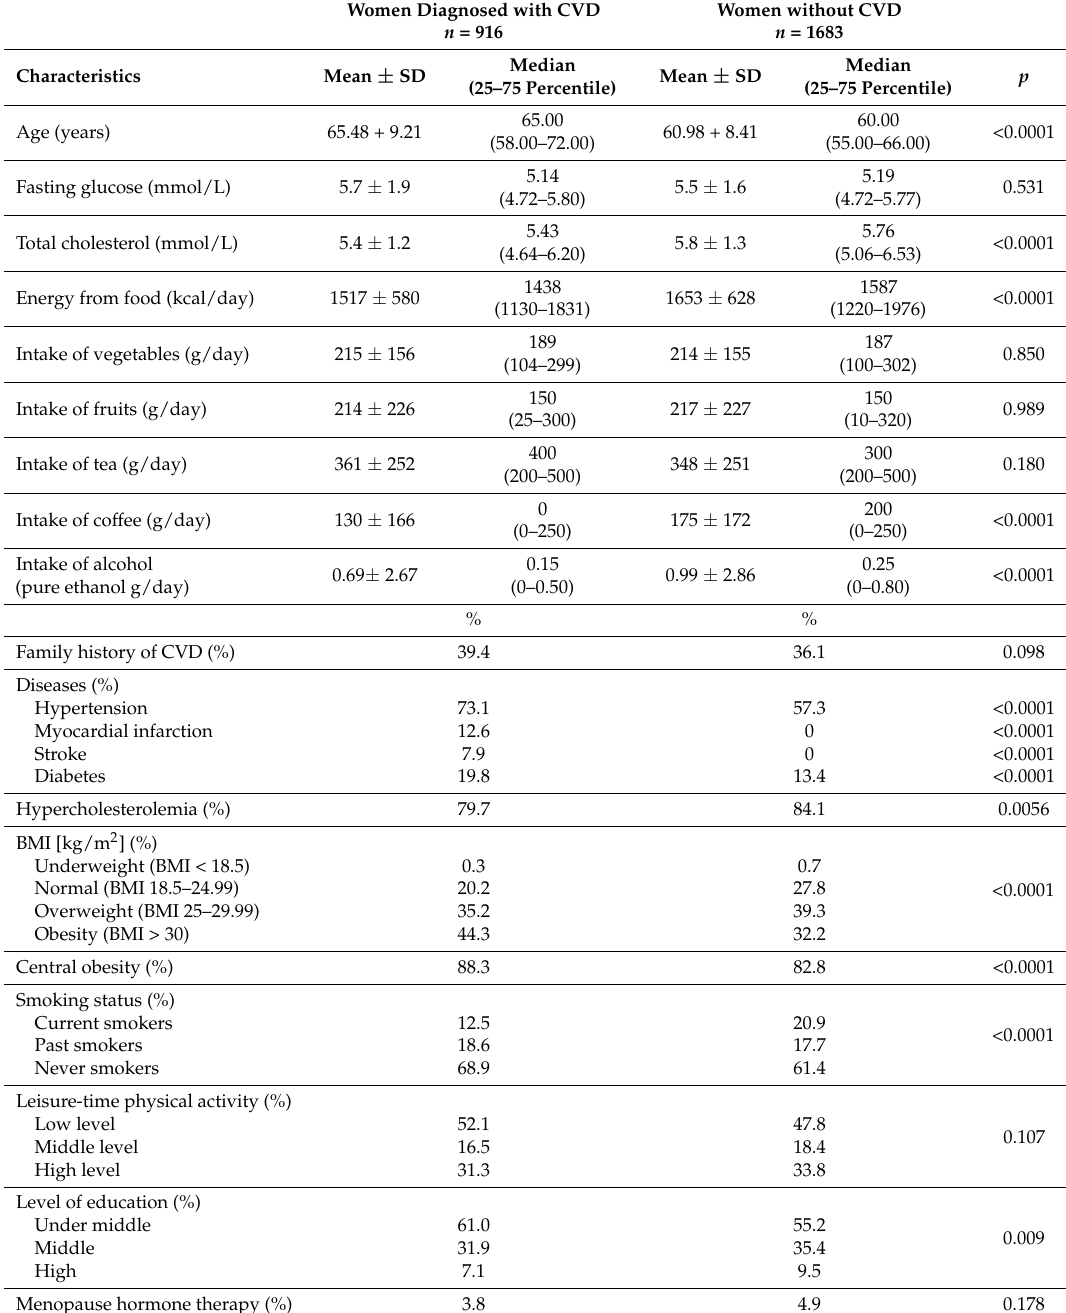
Table 1. Descriptive statistics of the studied postmenopausal women with and without CVD